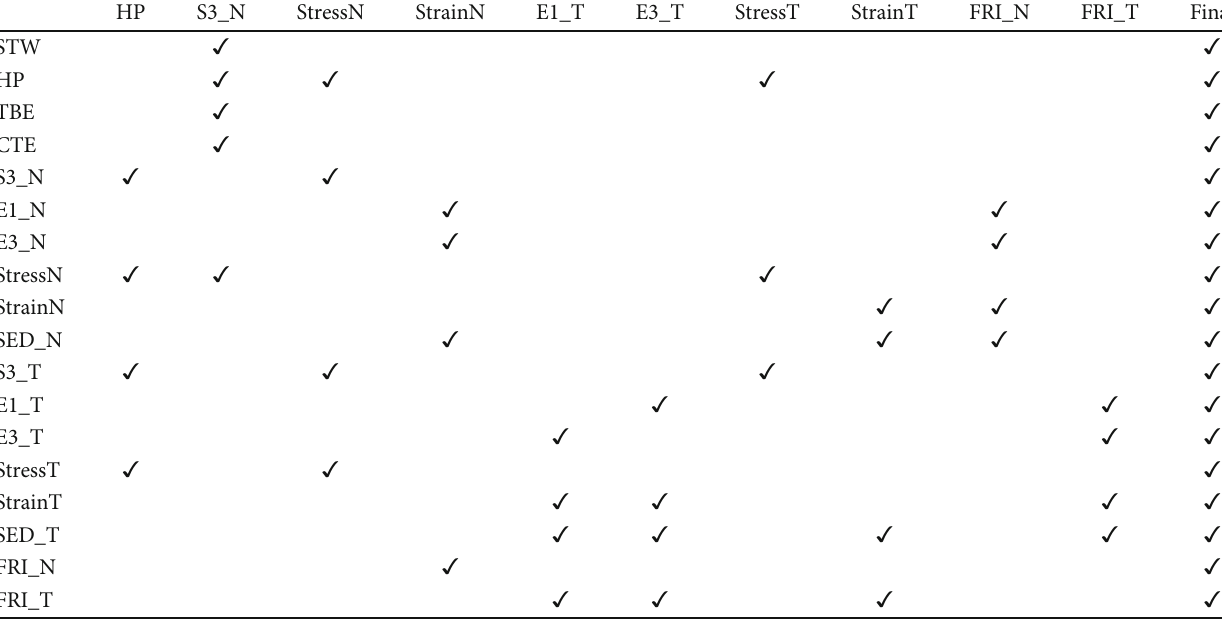
Table 7: Variables whose correlation is higher than 0.9 and was not included by PCA are shown in the columns. The rows show variables that are highly correlated with the column attributes, coded by the check sign.